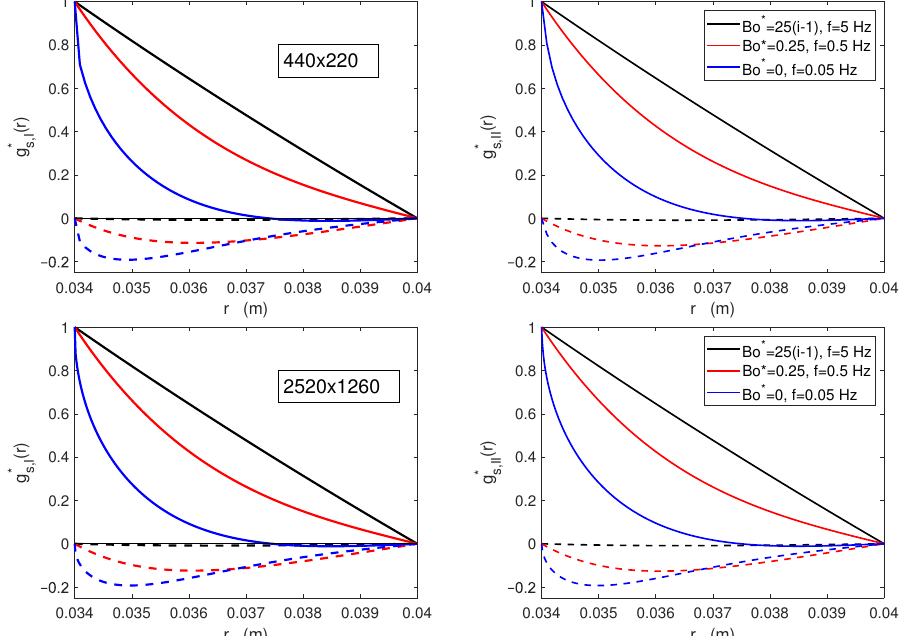
( r ) (left) and g ∗ ( r ) (right) for ω and Bo ∗ values as in Figure 4. Real and imaginary parts of g ∗ s , I s , II Figure 3. Top row: 440 × 220 mesh. Bottom row: 2520 × 1260. Continuous and dashed lines represent the real and imaginary parts, respectively. Case A: High frequency with a viscoelastic interface (black). Case B: Medium frequency with purely viscous interface (red). Case C: Low frequency and clean air–water interface